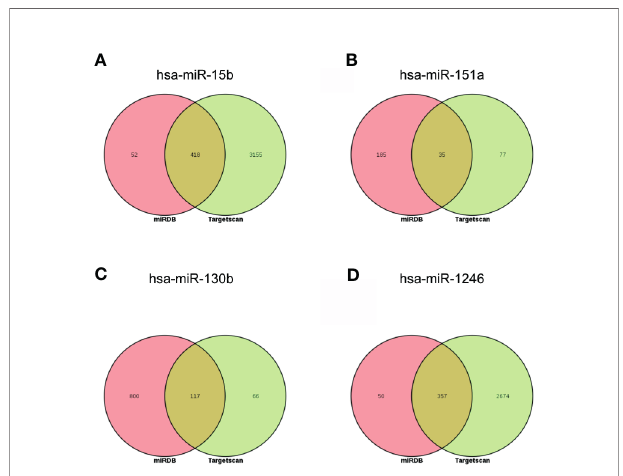
FIGURE 5 | The intersection analysis of predicted target genes of DEmiRNAs. (A) hsa-miR-15b-3p. (B) hsa-miR-151a-3p. (C) hsa-miR-130b-3p. (D)